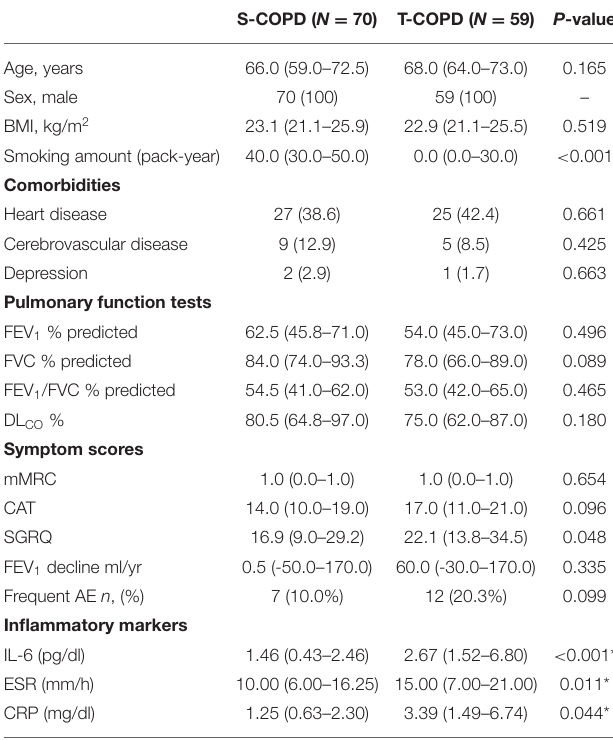
TABLE 1 | Demographics of patients with S-COPD and